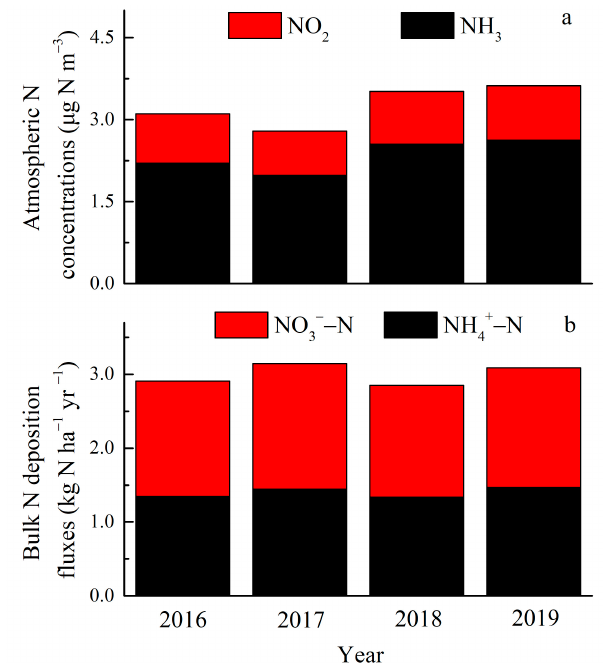
Figure 4. Variation in monthly atmospheric NO 2 ( a ) and NH 3 ( b ) concentrations. Di ff erent letters above the error bar means that the di ff erence reaches a significant level. Correspondingly, the same letters exists above the error bar that means the di ff erence is insignificant.